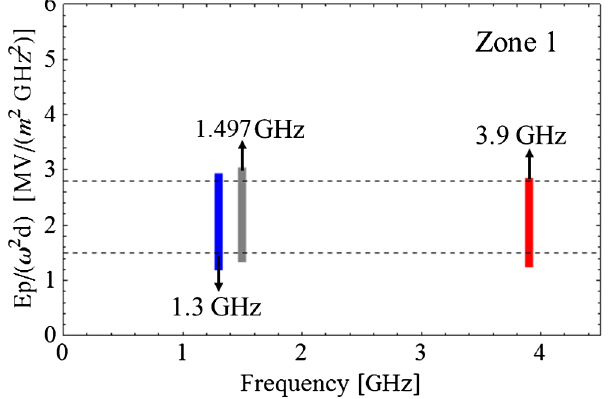
FIG. 12. Frequency scaling of zone 1 MP in HOM couplers of real cavities including the 1.3 GHz ILC cavity, 1.5 GHz CEBAF upgrade cavity, and original 3.9 GHz third harmonic cavity. The dashed lines are the lower and upper bound from the analytical prediction based on the parallel-plate model.